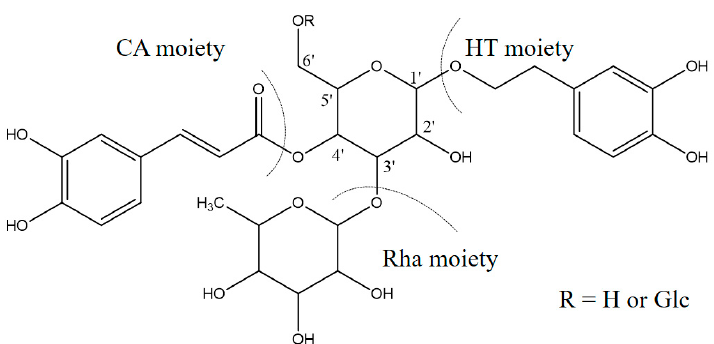
Figure 8. The common fragmentation positions of these PhGs.